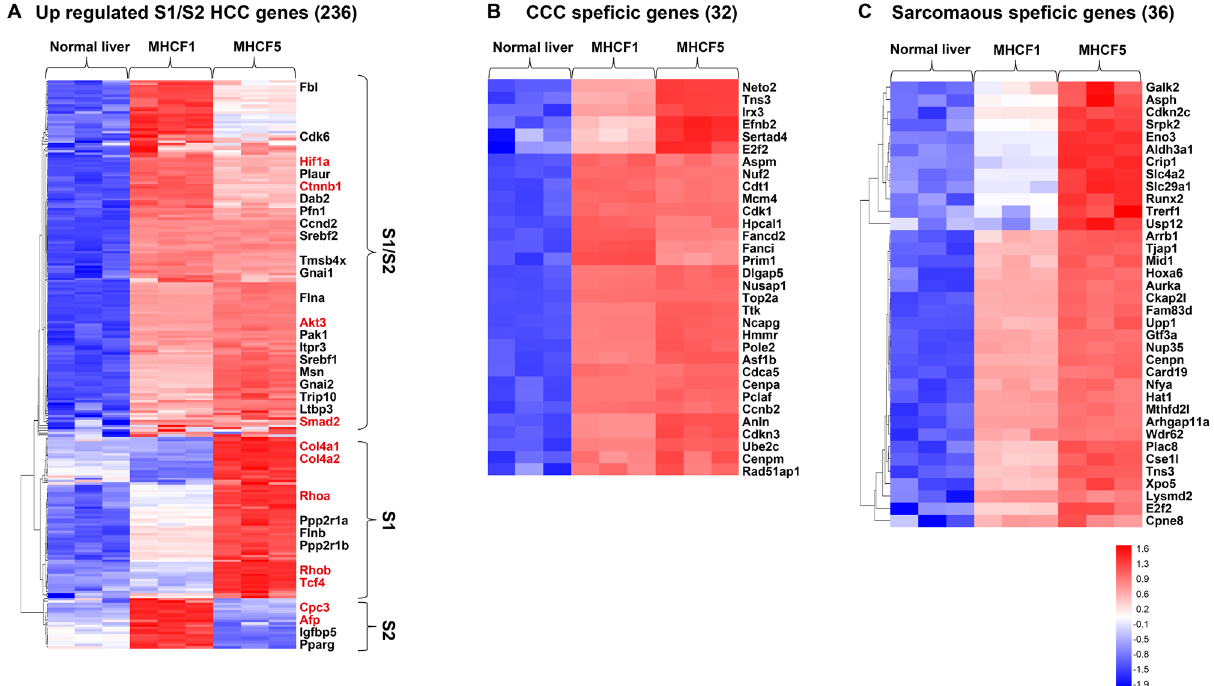
Figure 5. One-way hierarchical clustering of MHCF1 cells, MHCF5 cells, and healthy liver. ( A ) One-way hierarchical clustering of MHCF1 cells, MHCF5 cells, and healthy liver using 236 upregulated S1/S2 HCC genes. ( B ) One-way hierarchical clustering of MHCF1 cells, MHCF5 cells, and healthy liver using 32 CCC- specific genes. ( C ) One-way hierarchical clustering of MHCF1 cells, MHCF5 cells, and healthy liver using 36 sarcomatous-specific